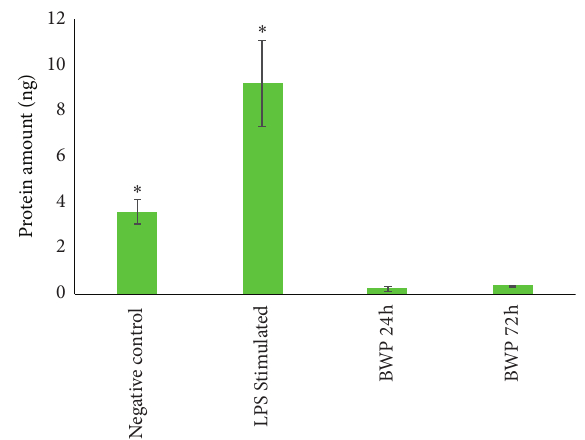
Figure 4: MMP-9 secreted by macrophages (3.55 × 10 5 cells per sample) when cultured without treatment (negative control), 1 µ g/ mL LPS (LPS Stimulated), or BWP for 24 and 72h. ∗ denotes statistical significance ( P < 0 . 01).